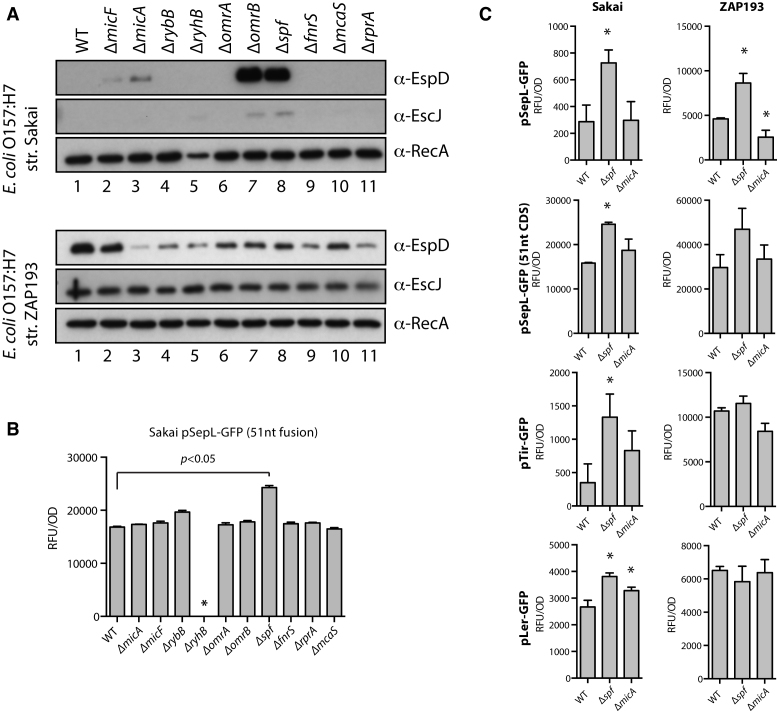
Analysis of sRNA mutations on type 3 secretion and specific LEE transcripts. (A) Western blot analysis for EspD (supernatant), EscJ (whole cell) and RecA (whole cell control) from WT and sRNA deletion mutants of E. coli O157:H7 strains Sakai (low T3 secretor) and ZAP193 (high T3 secretor). (B) Bar graphs showing relative expression levels of the SepL+51-GFP fusion (see text for details) in the WT and sRNA deletion backgrounds of E. coli O157:H7 strain Sakai. The asterisk indicates that the mutant did not grow to an OD600 >0.6 under our experimental conditions. (C) Translation of the LEE encoded proteins Ler, SepL and Tir was monitored in WT, Δspf, and ΔmicA backgrounds for both low T3 secretor strain Sakai, and high T3 secretor strain ZAP193. Asterisks indicate P< 0.05.